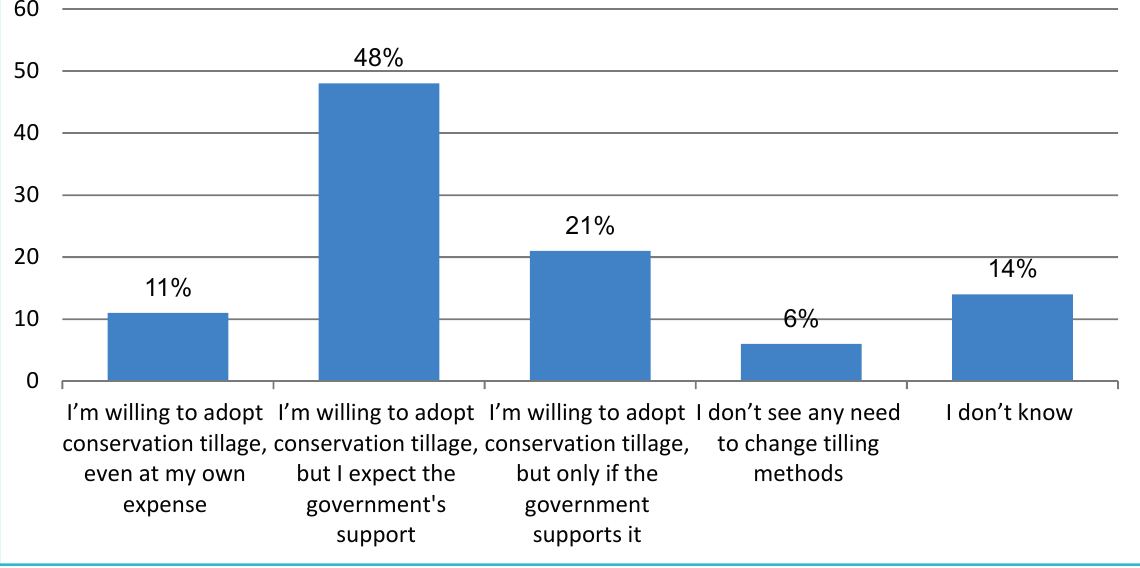
Figure 2. The perspectives of the public regarding the adoption of conservation tillage and who should pay for it.